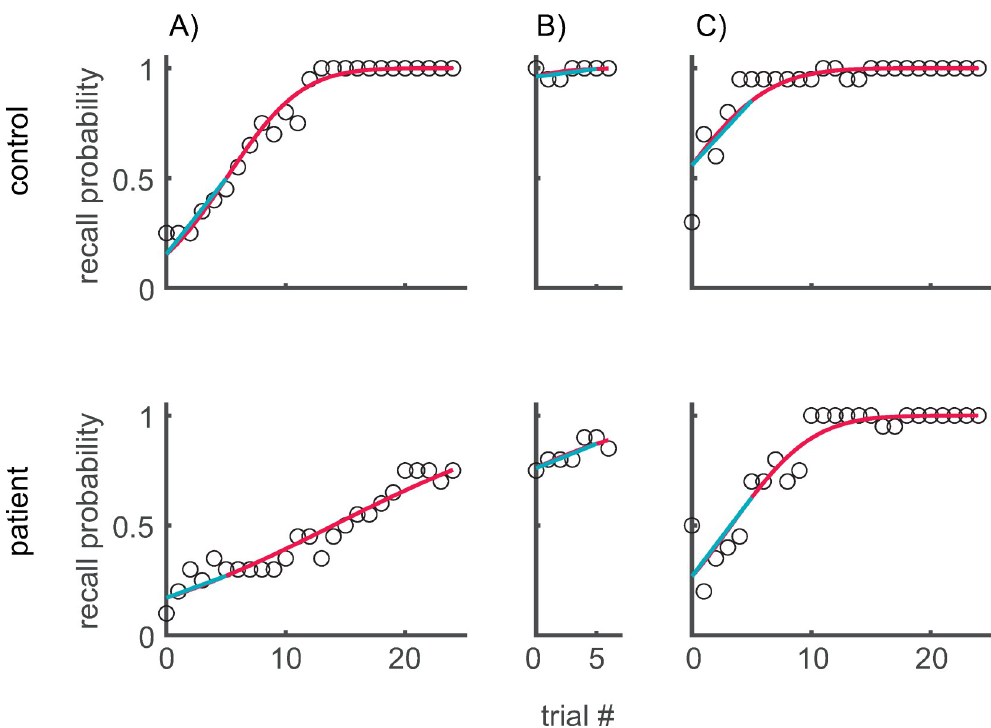
Fig 3. Learning progress for two individuals (Top: control; Bottom: patient) during the three learning blocks. Circles show the recall probability, defined as the fraction of the number of recalled targets with respect to the number of presented targets (i.e. the sequence length N = 20) for each reproduction (trial #). Red line: The approximation of the recall probability by a generalized regression (probit-fit). Cyan: The line starting at the initial recall probability and the slope equal to the mean learning progress (increment of the recall probability) averaged across the first 5 trials. The slope of this line is used to define the initial learning speed. A) initial training, B) retention test starting 30 min after the end of the initial training, C) training session one week after the initial